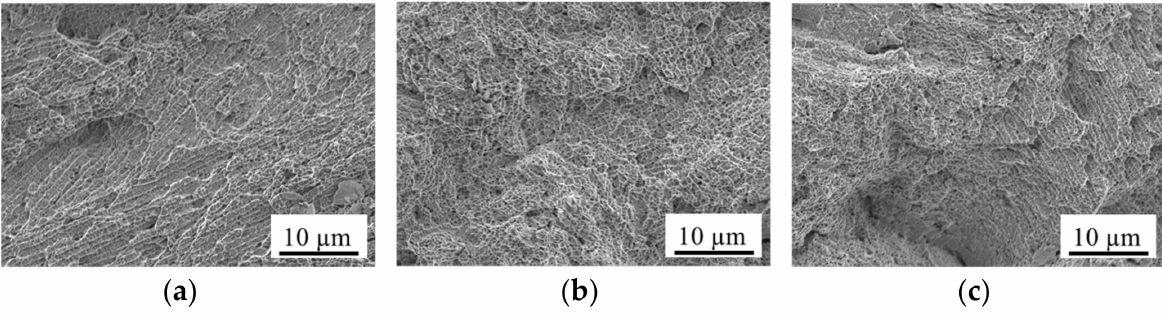
Figure 14. Fractured surfaces of the as-built specimens fabricated in the direction of ( a ) 0 ◦ , ( b ) 45 ◦ , and ( c ) 90 ◦